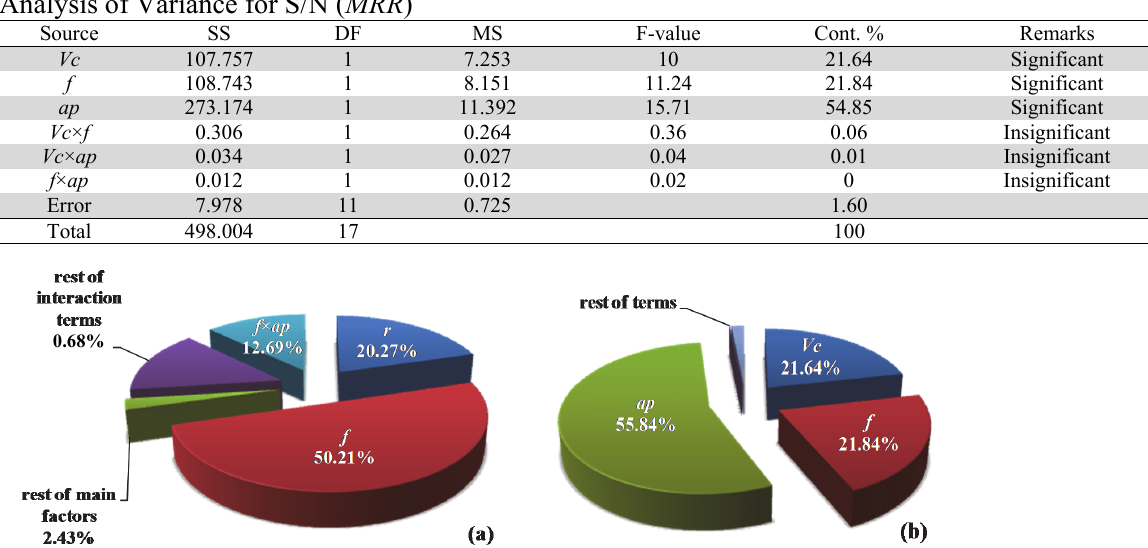
Fig. 3. Contribution of significant terms on: (a) Surface roughness ( Ra ), (b) Material removal rate ( MRR